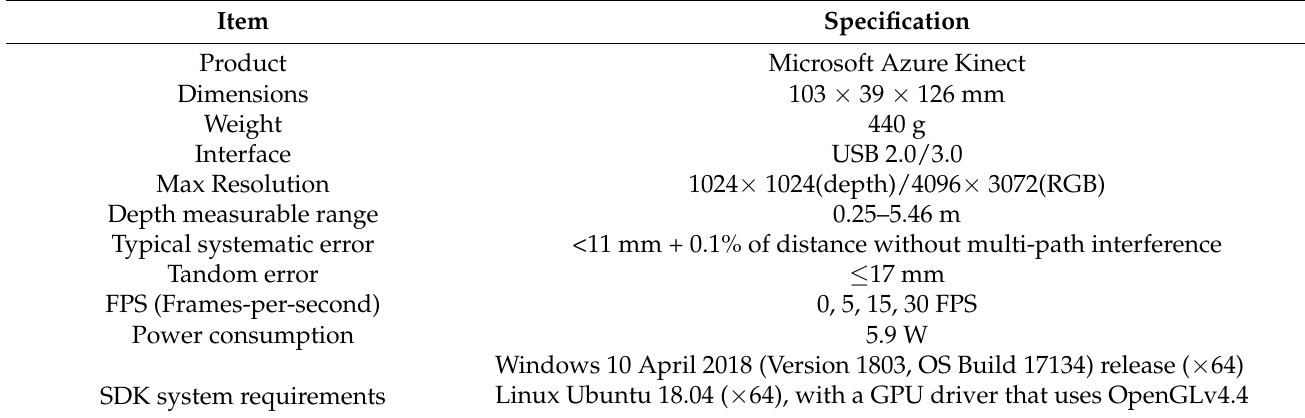
Table 5. Specifications of Microsoft Azure Kinect.